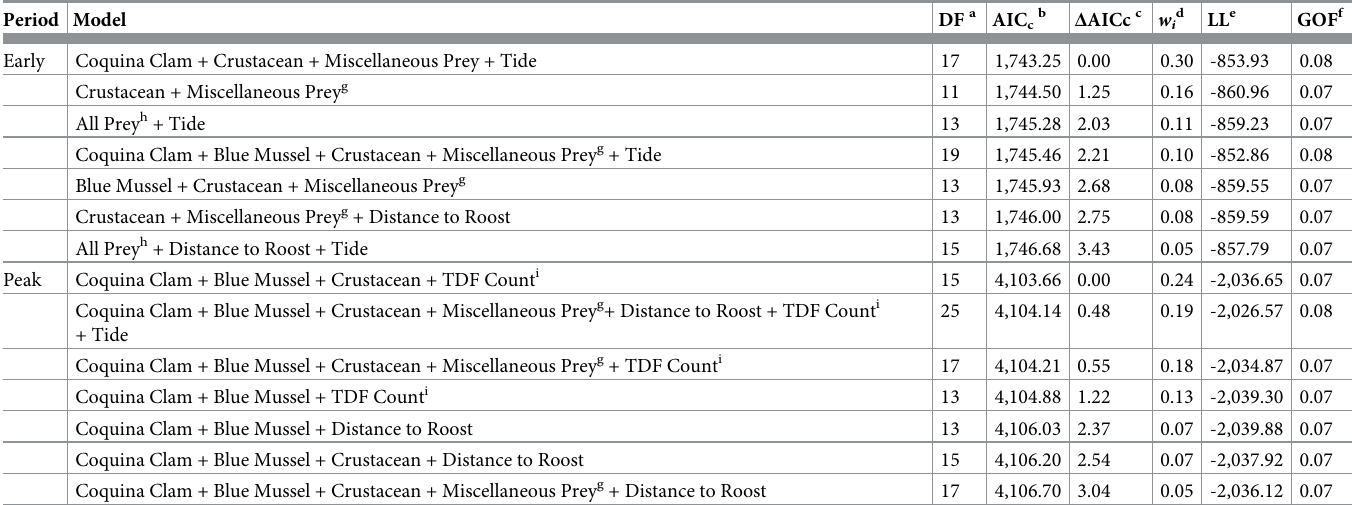
Table 1. Zero-inflated negative binomial mixed-effects regression models predicting red knot presence and flock size on peat substrate early in red knot migration (May 14–20, 2008–2018, except 2010; n = 457; ‘early’), and on sand and peat substrates at the approximate peak of red knot migration (May 21–27, 2007–2018; n = 1,322; ‘peak’), Virginia’s barrier islands. All models had the same covariates on both the zero-inflated and count processes and contained “Island” and “Year” as ran- dom effects. Period